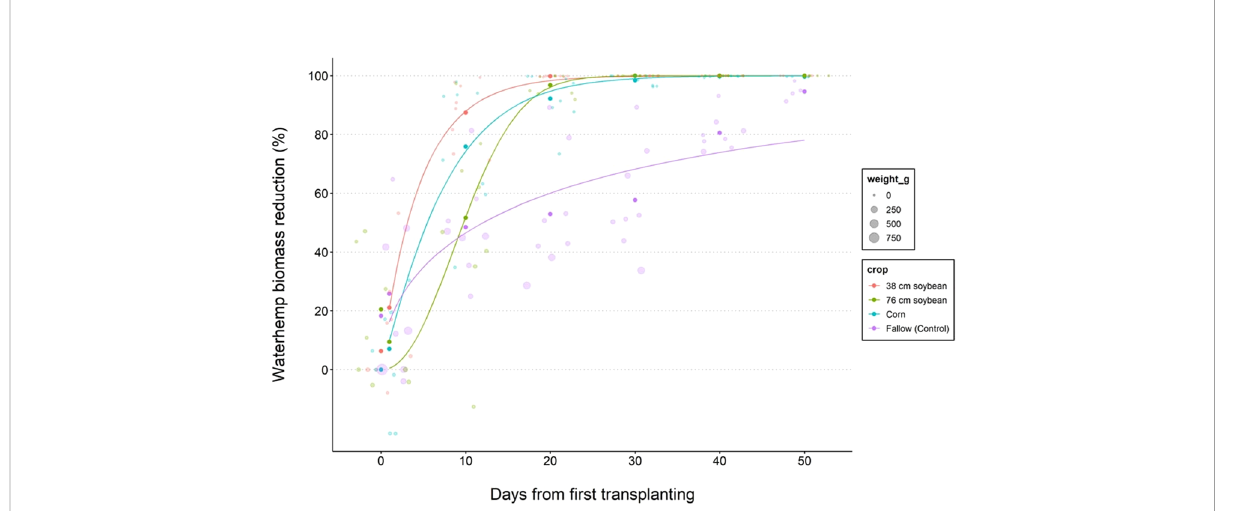
FIGURE 2 Nonlinear regression 3-parameter Weibull 2 models depicting reduction of waterhemp biomass for 38 (narrow) and 76 (wide) cm row spacing soybeans, corn (76 cm row spacing), and fallow treatment. Data lines represent the best model fi t for cumulative waterhemp biomass regressed on the days from the fi rst transplant timing. Waterhemp transplanting started on June 14 in 2019, and June 9 in